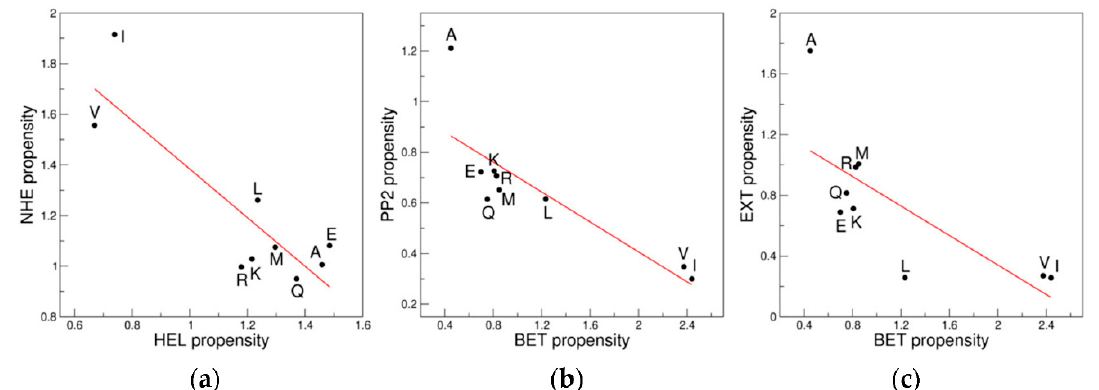
Figure 2. Anticorrelations of the propensity scales of proximal clusters: ( a ) HEL versus NHE; ( b ) BET versus PP2; and ( c ) BET versus EXT. The 9AA ensemble is considered.